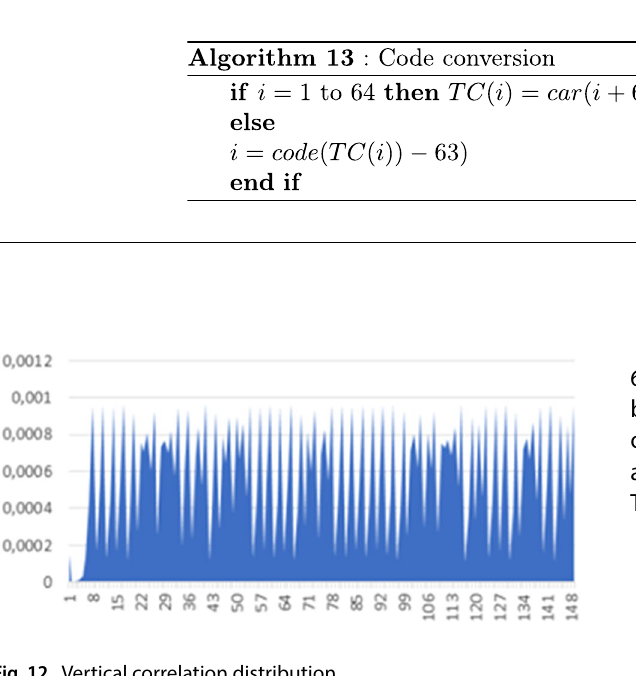
Fig. 12 Vertical correlation